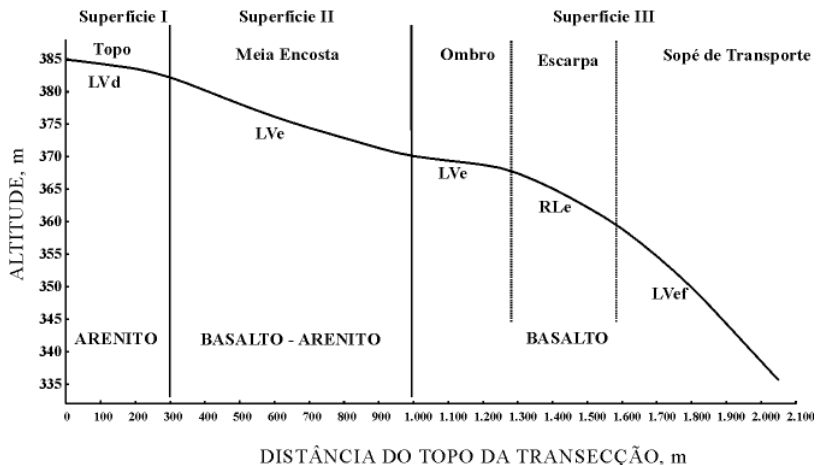
Figura 2. Perfil topográfico das superfícies geomórficas e os segmentos de vertente na transeção estudada e as respectivas classes de solos e substrato rochoso. (LVd = Latossolo Vermelho distrófico típico textura média A proeminente; LVe = Latossolo Vermelho eutrófico típico textura média A proeminente; LVe = Latossolo Vermelho eutrófico típico textura média A chernozêmico; RLe = Neossolo Litólico eutrófico típico textura média A moderado; LVef = Latossolo Vermelho eutroférrico chernozêmico textura argilosa A